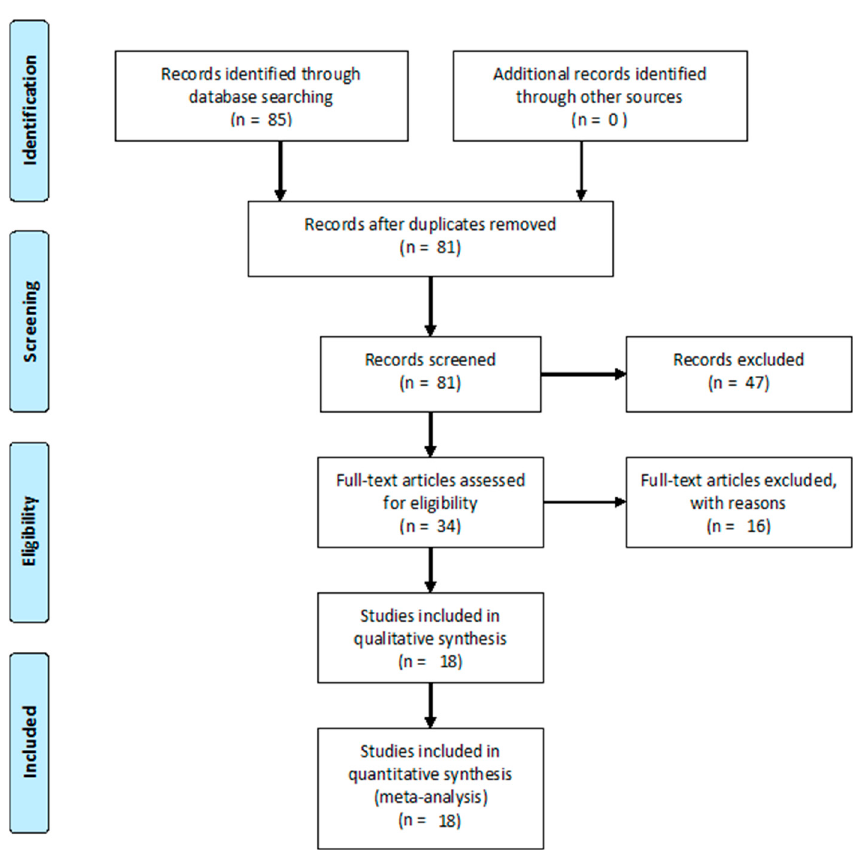
Figure 2. PRISMA 2009 flow diagram of the review process.